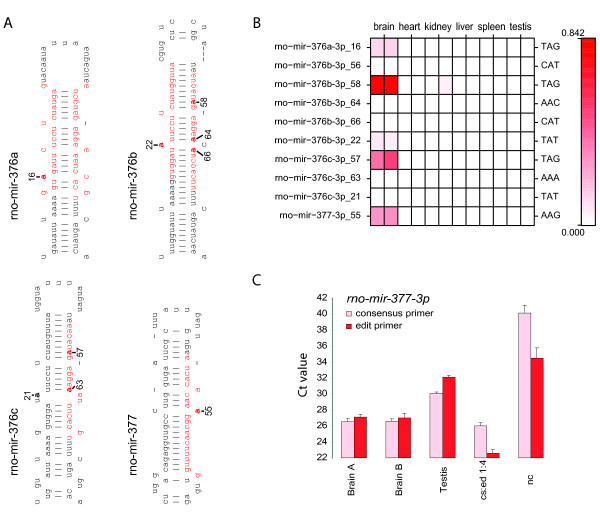
Edited miRNAs. A) miRNAs of which at least 10% was found to be edited. Shown are the precursors in their predicted folding structure. Red sequences represent miRNAs that are covered in our DGE profiles, bold "a"s along numbers indicate known and newly detected editing positions. B) Fractions of edited vs consensus miRNAs. Columns represent duplicates from each tissue, rows indicate miRNAs and edited position on the precursor. The red intensity reflects the fraction of edited miRNAs (edited miRNAs on this position/(edited + consensus miRNAs)). The triplets on the right side reflect the wild-type allele of which the middle adenosine is edited. C) qPCR data for mir-377. The first two bars describe results obtained from brain, the only tissue from which mir-377 was cloned. The ΔCt in brain corresponds to a ~2.7 fold higher expression of the consensus compared to the edited miRNA. Testis served as a negative input control. The specificity of the primers is indicated by the synthetic consensus and edited miRNA, mixed in a 1:4 ratio (cs: consensus, ed: edited). nc: primers only.